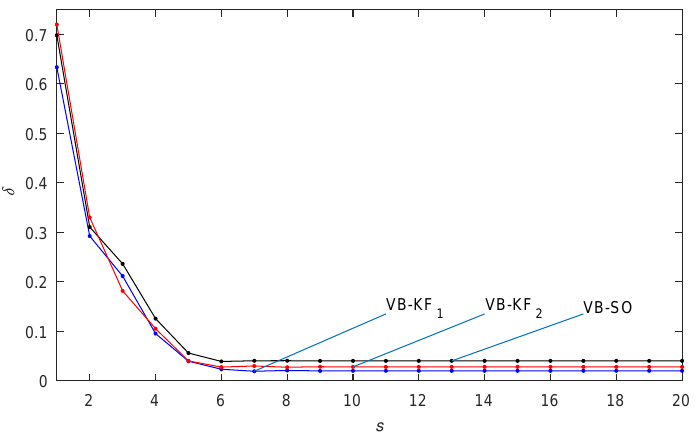
Figure 5. Comparison of estimation errors δ versus s under different algorithms ( σ 2 = 0.50 2 )